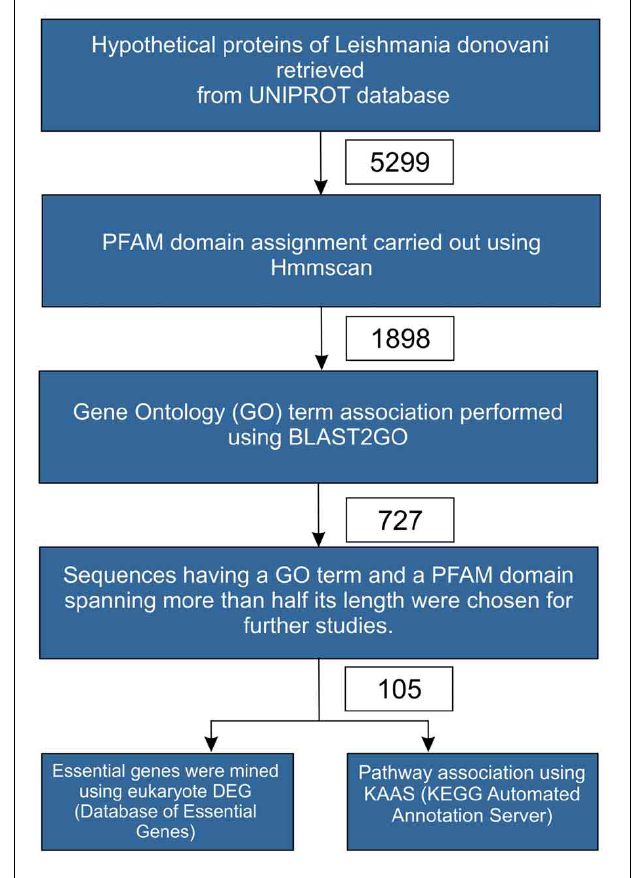
FIGURE 1 | Protocol used in sequence